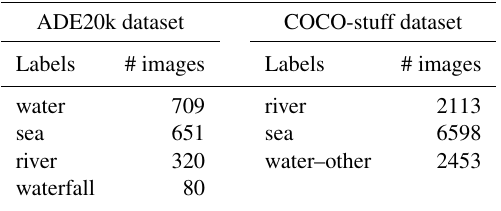
Table 1. Labels related to water bodies, and the number of images that contain at least one pixel with the corresponding